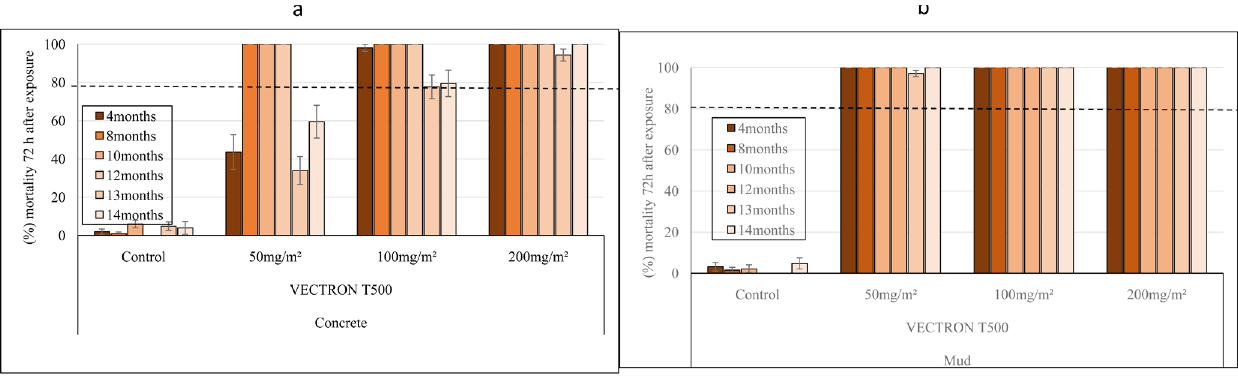
Figure 1. Monthly mortality of Anopheles gambiae s.s. Kisumu strain exposed on treated concrete ( a ) and mud ( b ) blocks substrates in World Health Organization (WHO) cones bioassay. Approximately 100 mosquitoes 2-5 days old were exposed for 30min to each treatment and mortality recorded 72 hours after exposure. Overall, 10 cones per dose and 10 mosquitoes per cone were used at each of tested mosquitoes at time point. Each histogram represents the mean mortality rate and error bars represent ± 95% confidence interval (CI). The dotted line represents WHO